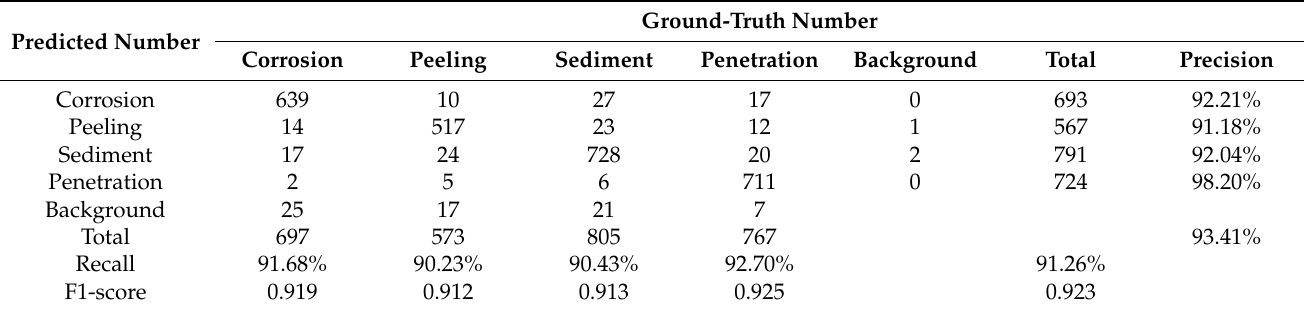
Table 3. Results of the defect detection model on generated images.